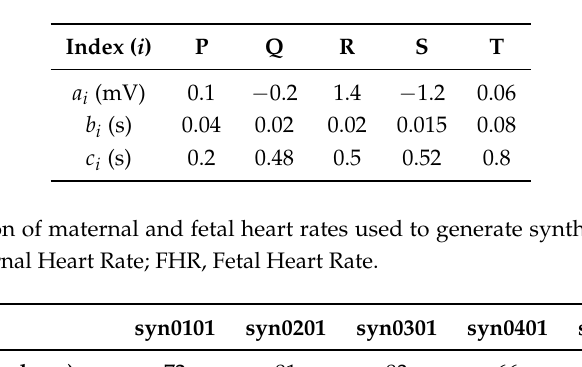
Table 2. Fetal ECG (fECG) model parameters.